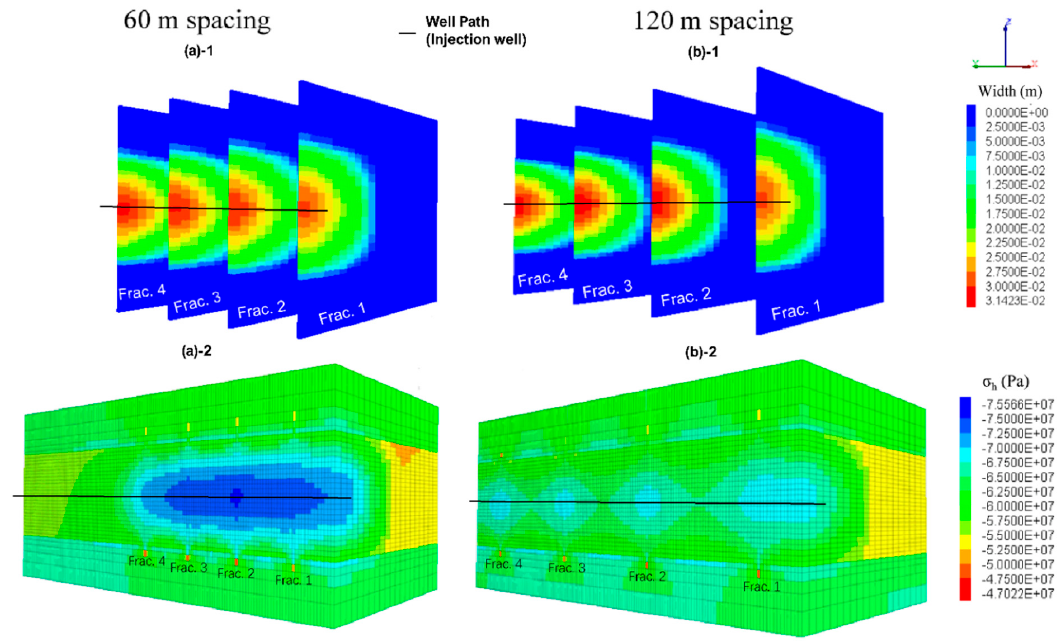
Figure 4. Comparison of fracturing results based on fracture width and stress shadow with fracture spacing of (a) 60 m and (b) 120 m.